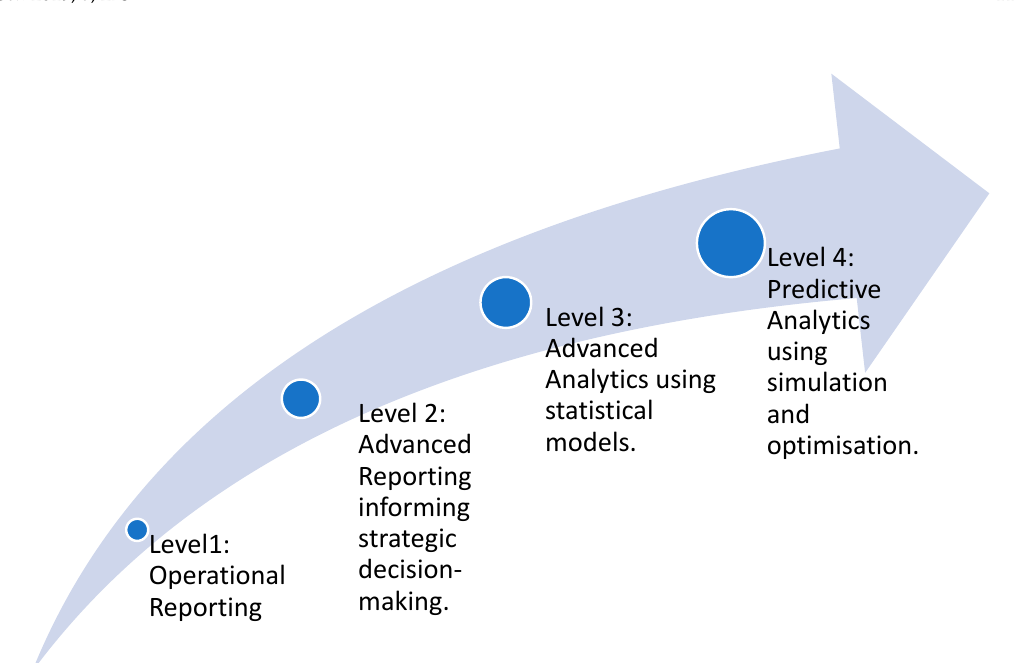
Figure 2. Talent analytics maturity model. Note: Adapted from Bersin (2012).